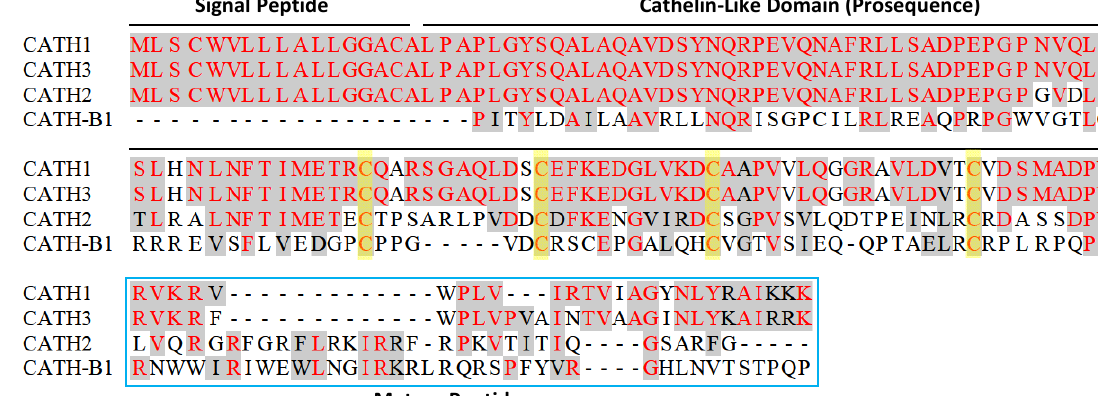
Figure 2. Amino acid sequence alignment of four chicken cathelicidins. Conserved sequences are shaded and identical residues are in red. Dashes are created to maximize the alignment. Each cathelicidin precursor consists of a conserved signal peptide sequence, a cathelin-like domain, and a variable C-terminal mature peptide sequence. Four cysteines in the cathelin-like domain are highlighted in yellow. Note that an N-terminal, 117-amino acid segment of CATH-B1 was omitted for